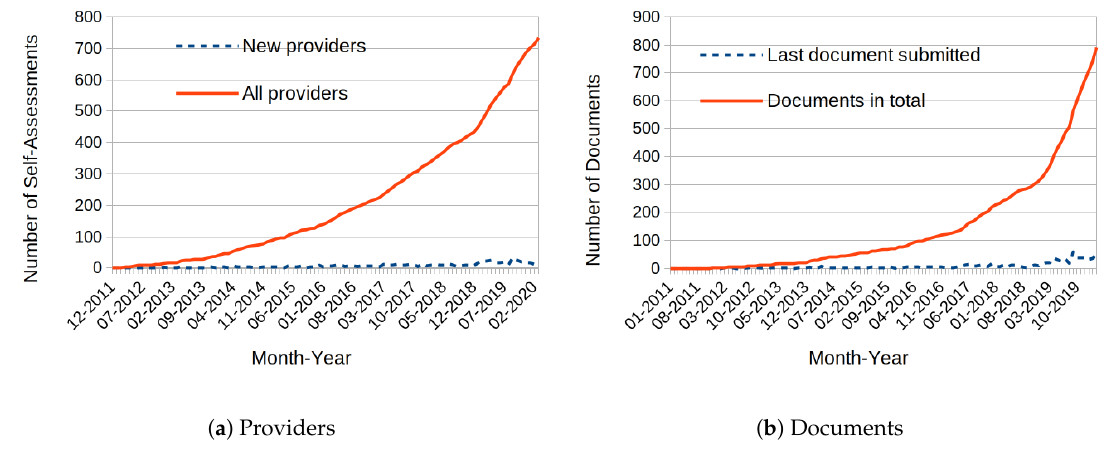
Figure 2. Submissions to Security, Trust and Assurance Registry